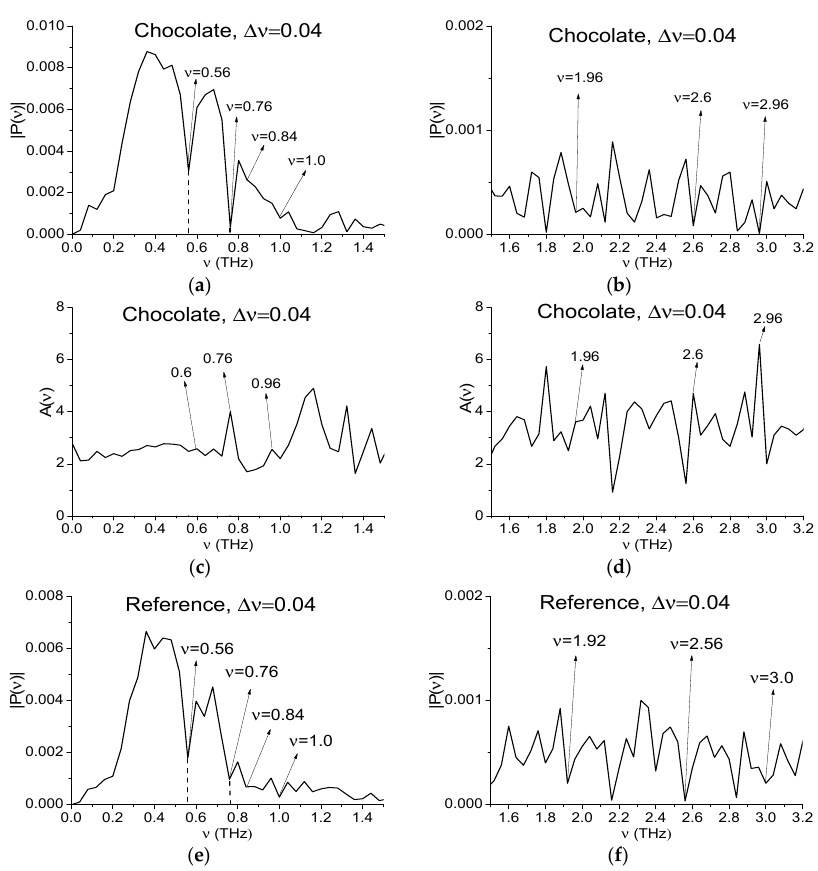
Figure 8. The Chocolate main pulse Fourier spectrum ( a , b ), Reference spectrum ( e , f ) and absorbance ( c , d ) in the frequency ranges ν = [0, 1.5] THz ( a , c , e ), [1.5, 3.2] THz ( b , d , f ) calculated with spectral resolution Δ ν = 0.04 THz.